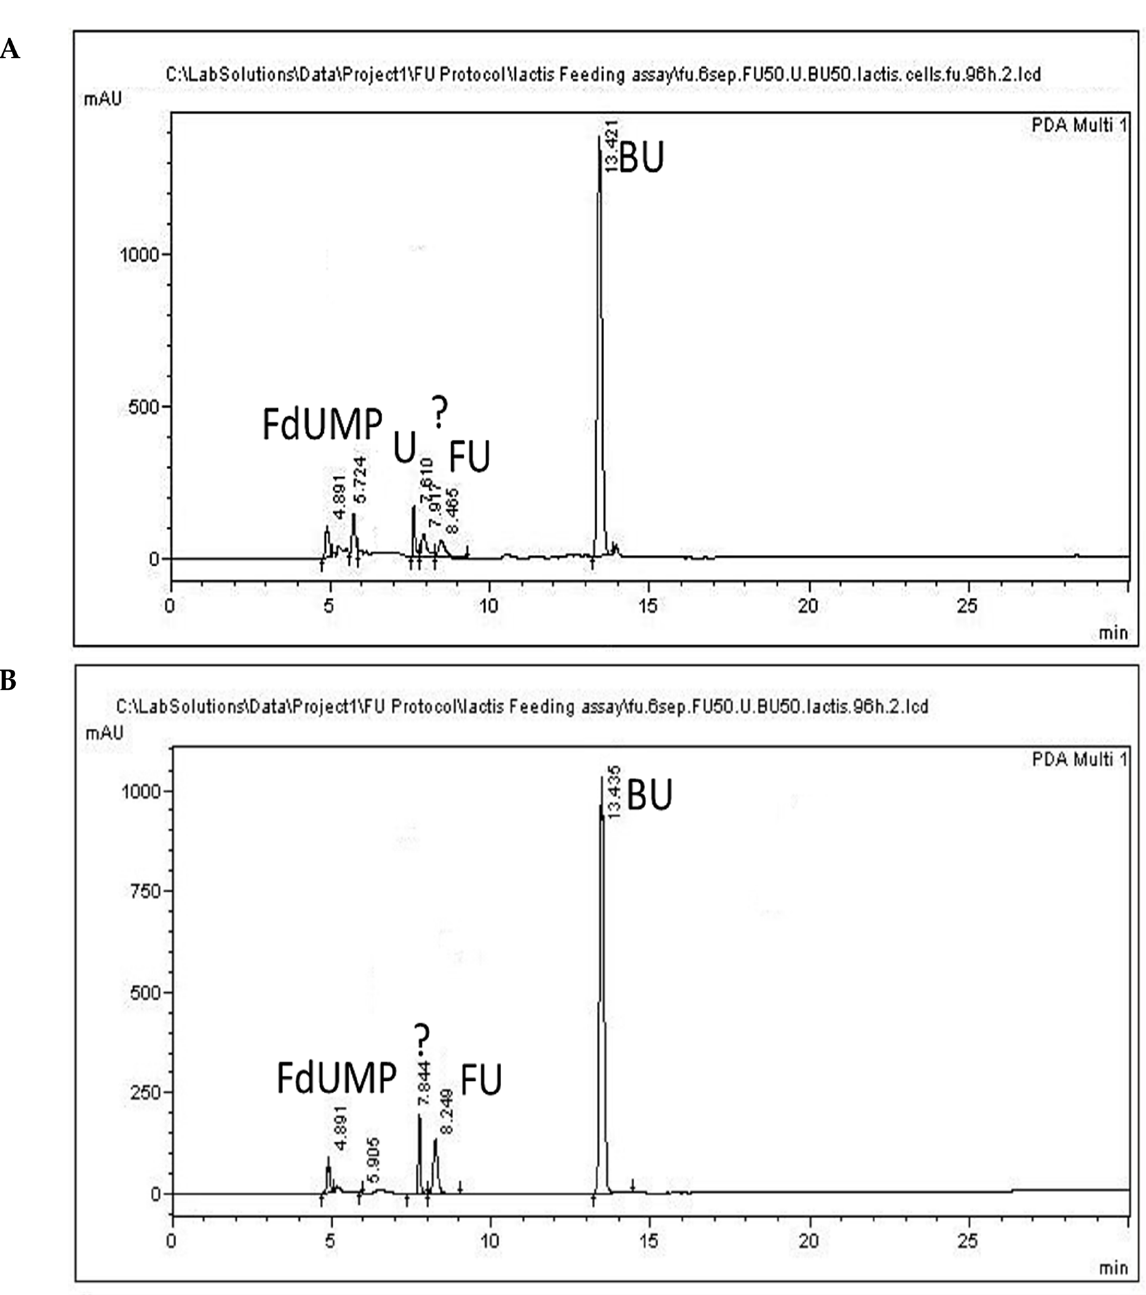
Figure 5. Representative chromatograms of cell precipitate ( A ) and cell-free culture supernatant ( B ) collected at 96 h, following administration of 5-FU (FU) (50 µ g/mL) at 0 h. Uracil and FdUMP are indicated as (U) and (FdUMP), respectively. An unidentified compound eluting at 7.9 min is indicated with a question mark.